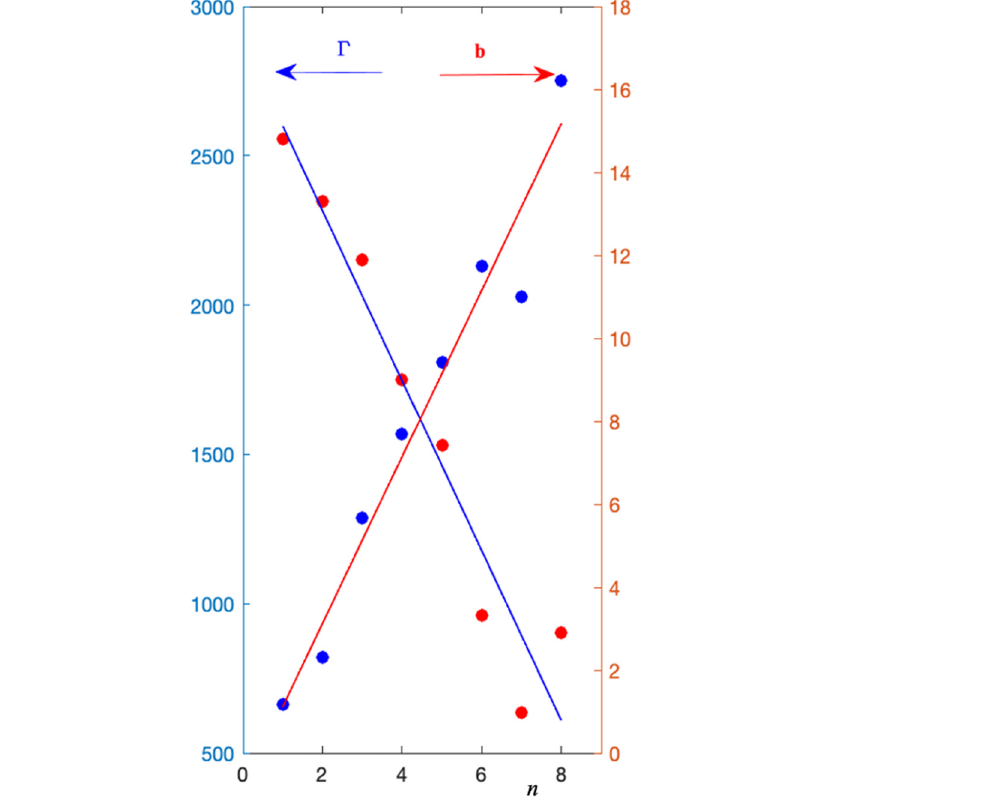
Figure 7. ( a ) Area under the emission band as a function of NR molar concentration. Although the concentration is low, the fluorescence exhibits a non-linear trend. ( b ) The wavelength of the maxi- mum emission as a function of NR molar concentration.